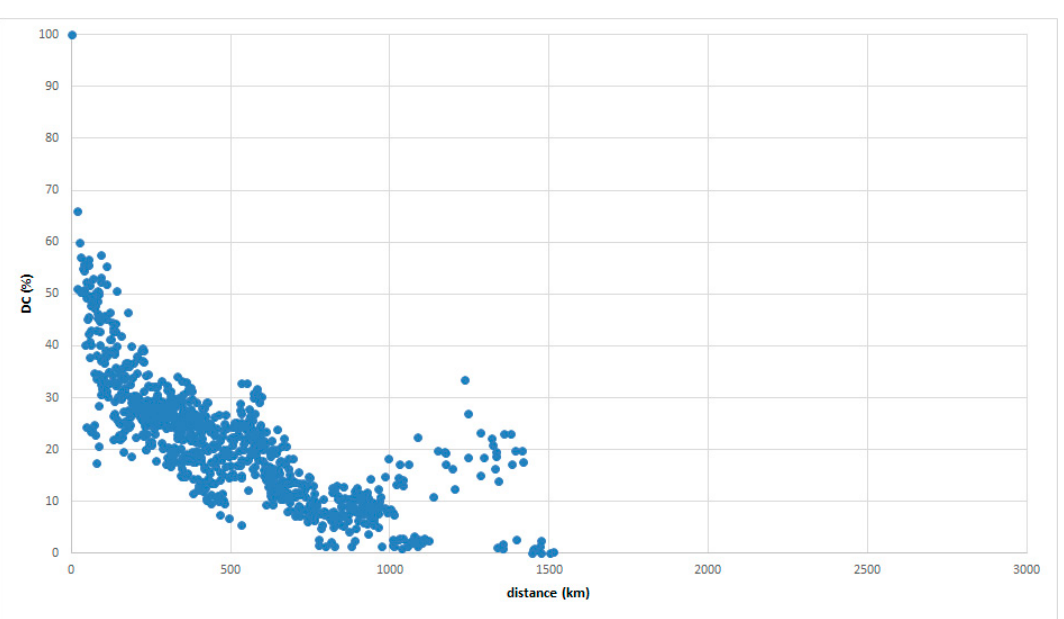
Figure 9. GAJ data with reference place in Chugoku.